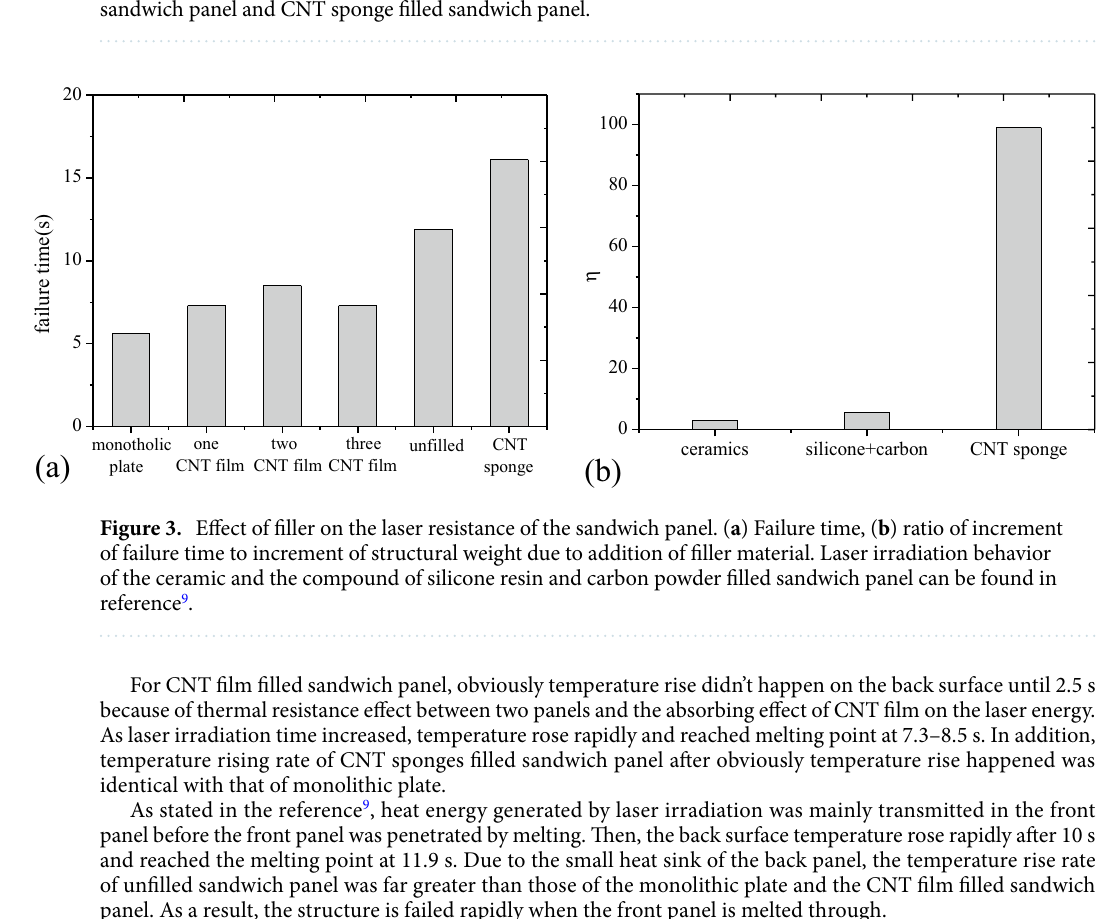
Figure 2. Comparison of temperature histories of monolithic plate, CNT film filled sandwich panel, unfilled sandwich panel and CNT sponge filled sandwich panel.